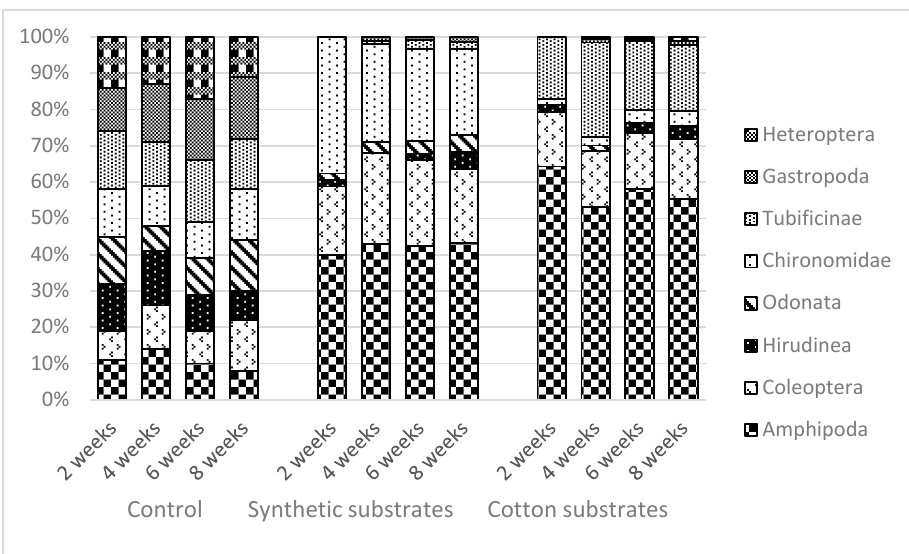
Figure 4. Dominance structure of particular taxonomics group of aquatica invertebrates (% in the total numbers substrate/m 2 of surfaces) in the different experimental variants.